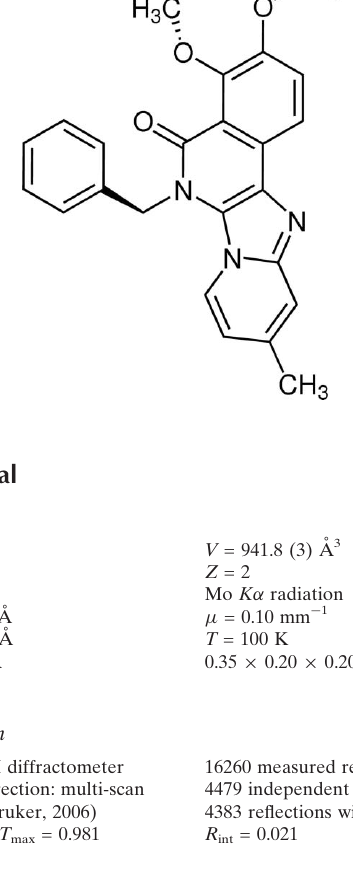
Data collection Bruker APEXII diffractometer Absorption correction: multi-scan ( SADABS ; Bruker, 2006) T min = 0.965, T max = 0.981